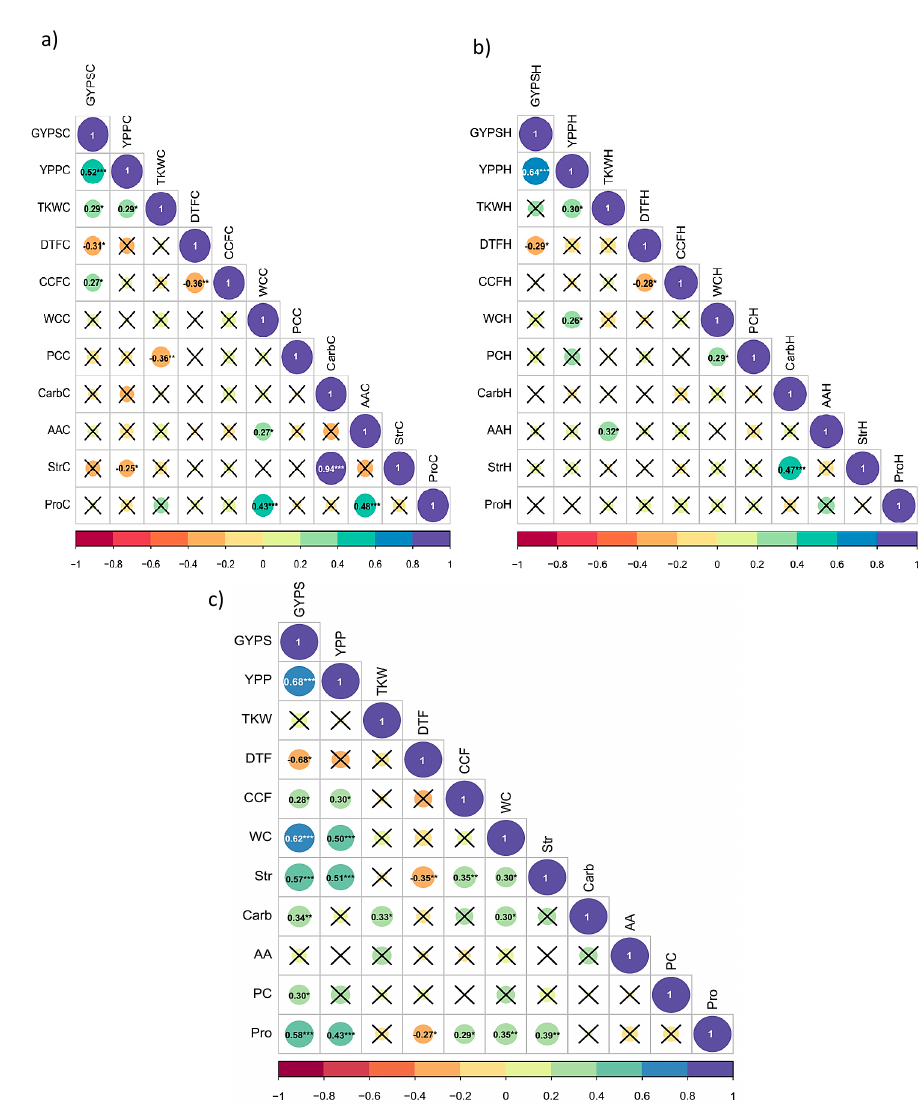
Figure 4. ( a , b ) Correlation of traits in barley ( a ) under control ( b ) under heat stress during pre-anthesis in barley. The full names and abbreviations of the traits are listed in Table 1. X indicates the non-significant correlations at p = 0.05; ( c ) correlation of the percentage changes in all traits in barley. The full names and abbreviations of the traits are listed in Table 1. X indicates the non-significant correlations at p = 0.05. *, **, and *** encode to significane levels at 0.05, 0.01 and 0.001,